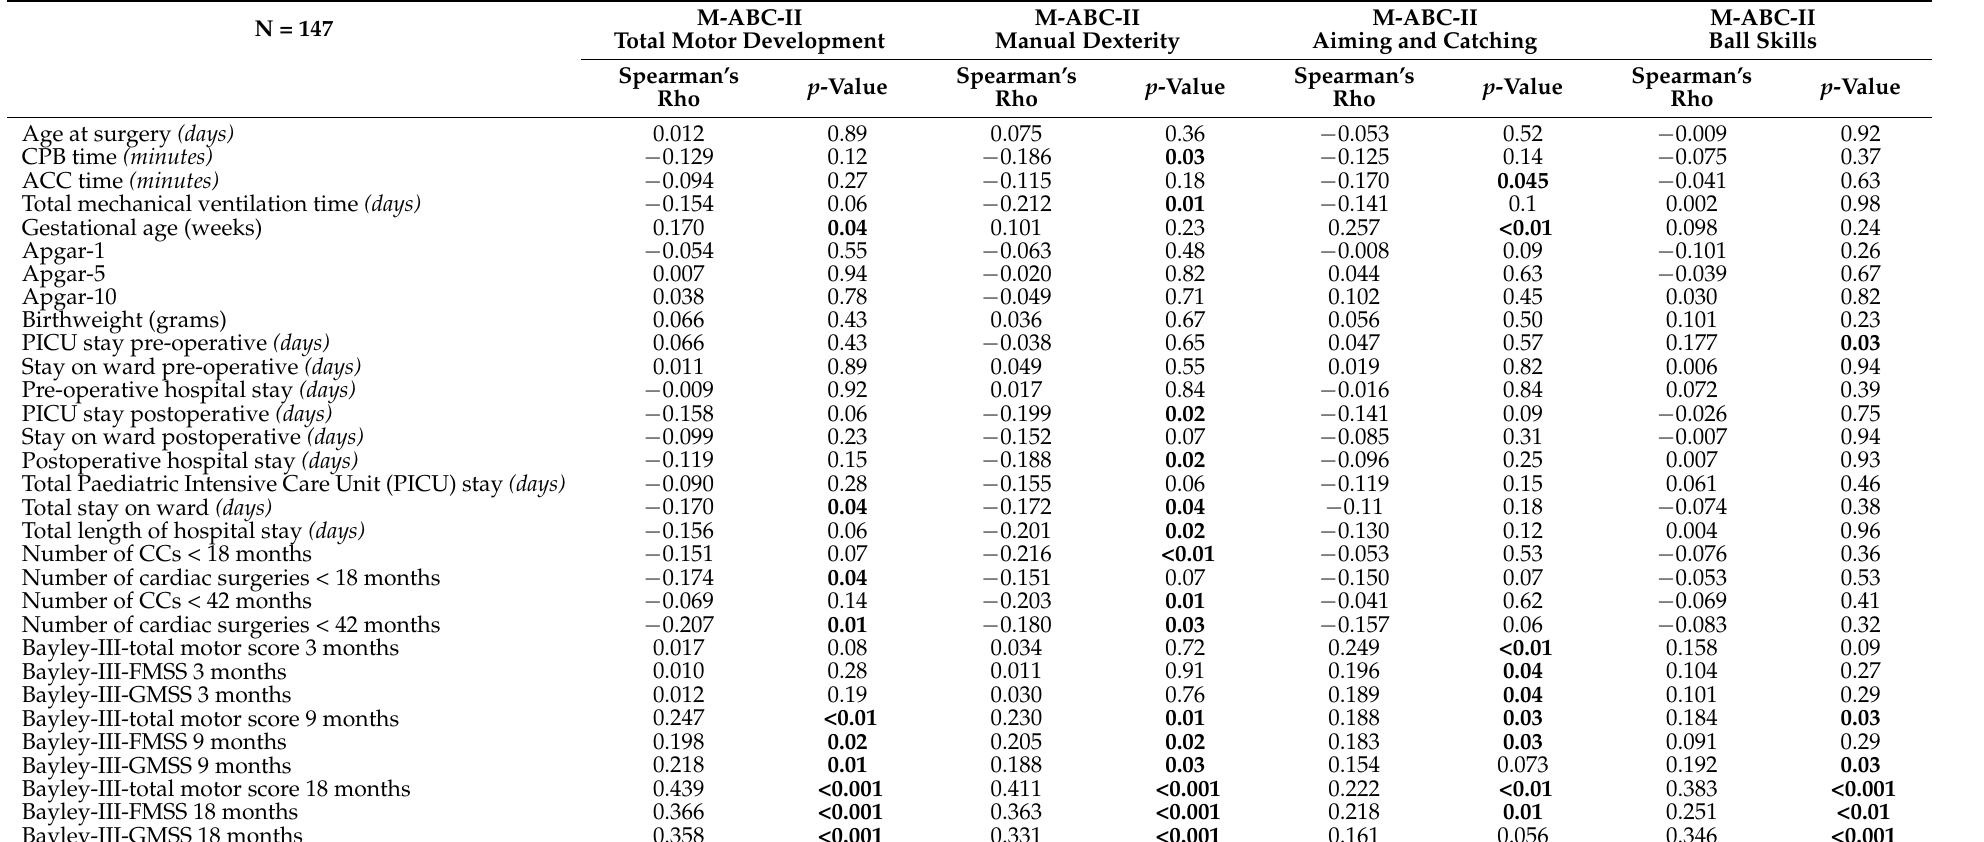
Table A2. Correlations between motor outcome and selected